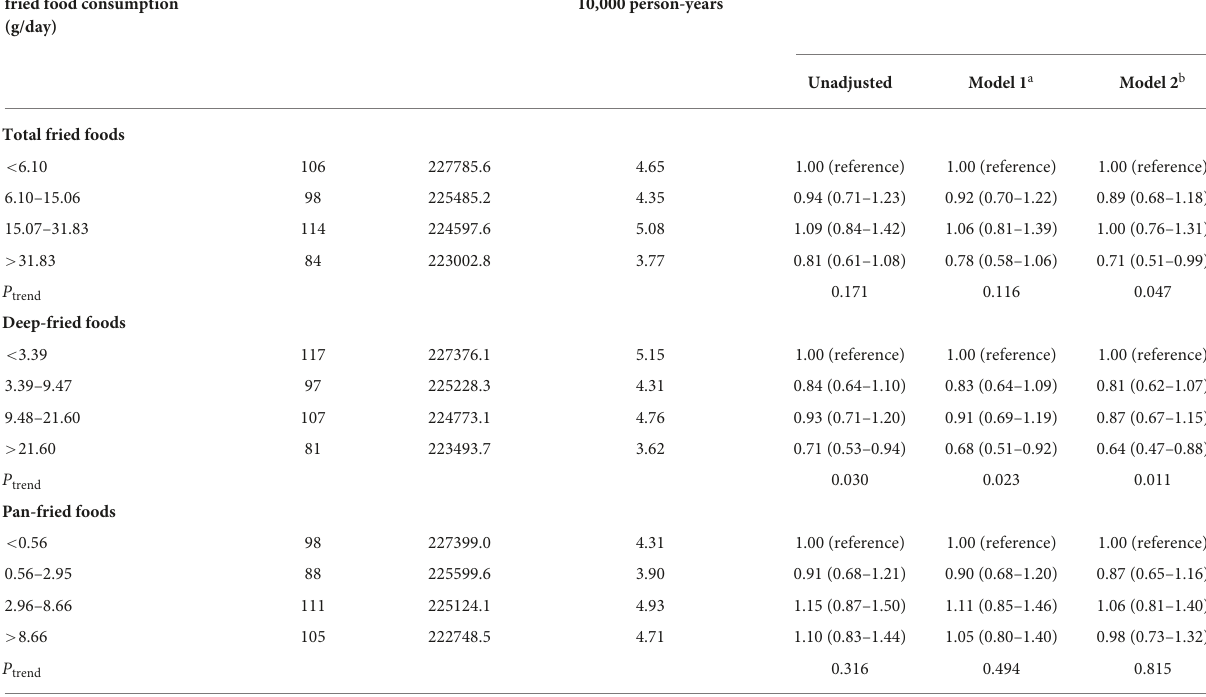
TABLE 2 Hazard ratios of the association between energy-adjusted fried food consumption and the risk of pancreatic cancer. Quartile of energy-adjusted fried food